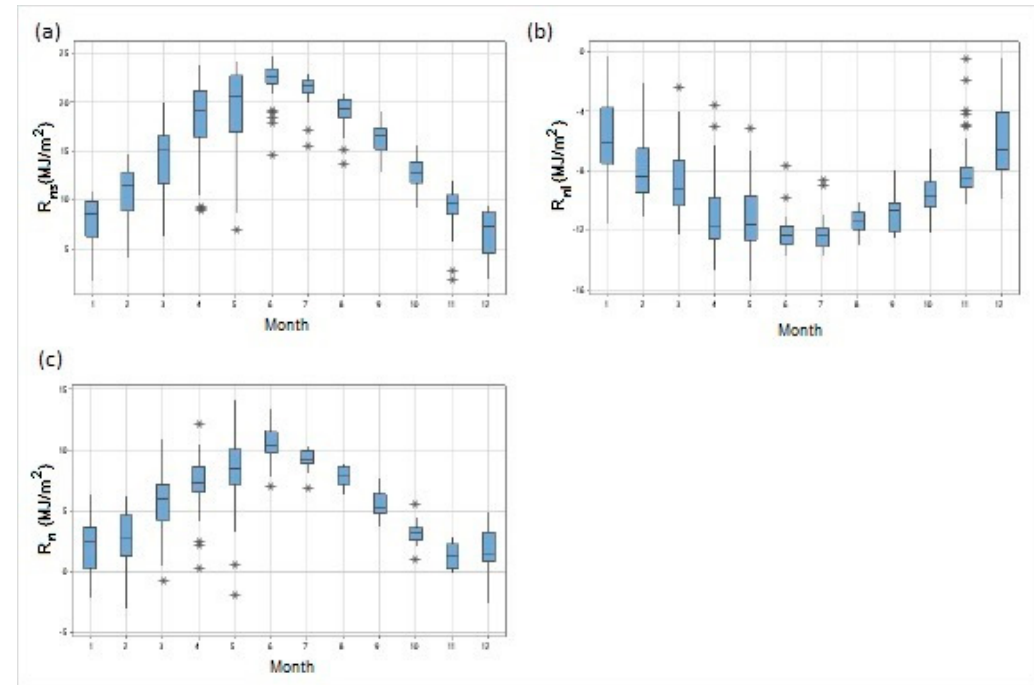
Figure 12. Monthly mean daily longwave and shortwave irradiation components.